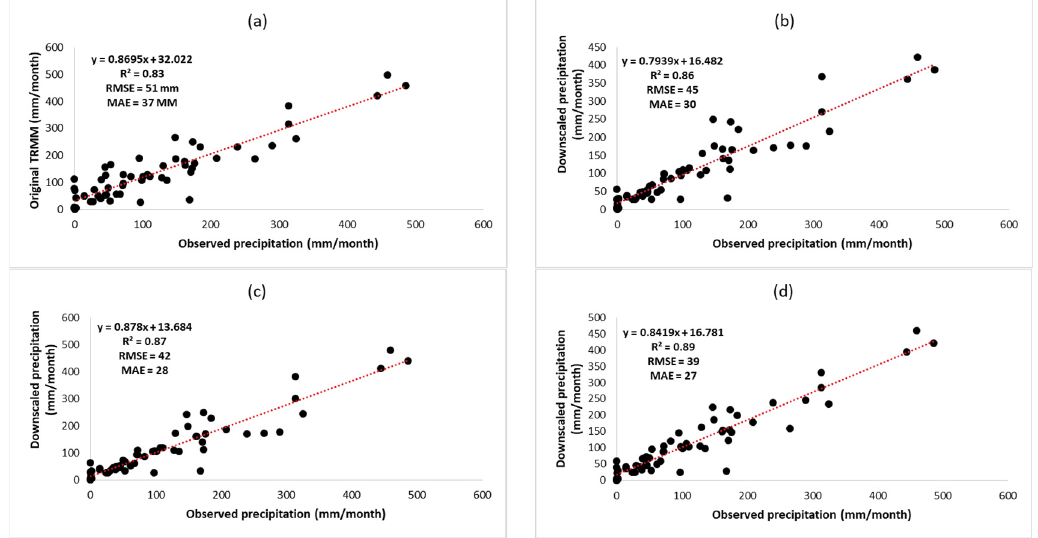
Figure 9. Validation results of the original TRMM ( a ) and the downscaled TRMM at 1 km by disaggregation using ANN algorithm and NDVI ( b ), EVI ( c ), and LAI ( d ) on a monthly scale from January to December 2018.